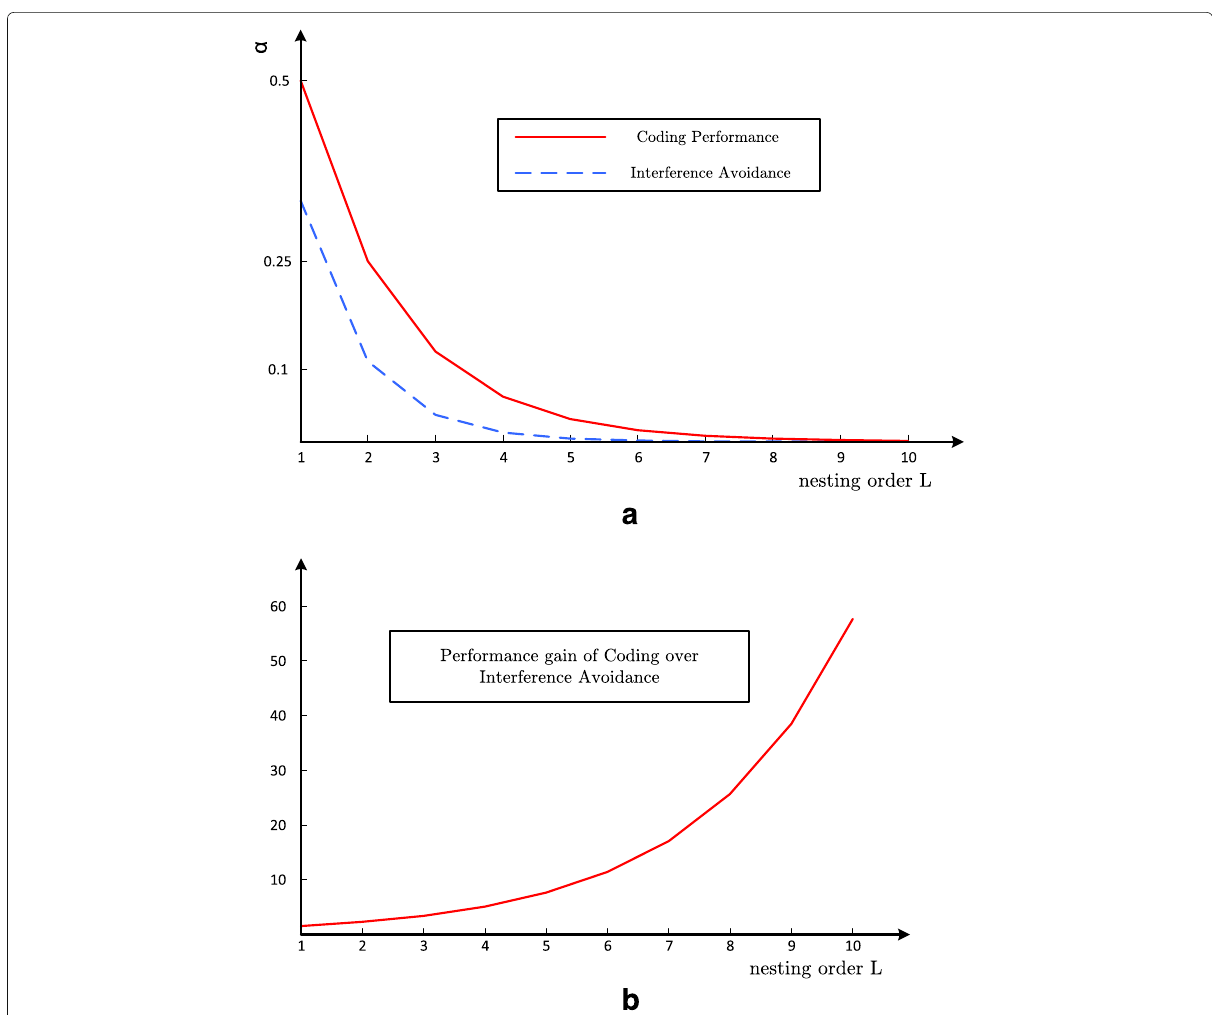
Fig. 17 a Achievable normalized sum rate of coding and interference avoidance in an L -nested folded-chain network and b the performance gain of coding scheme over interference